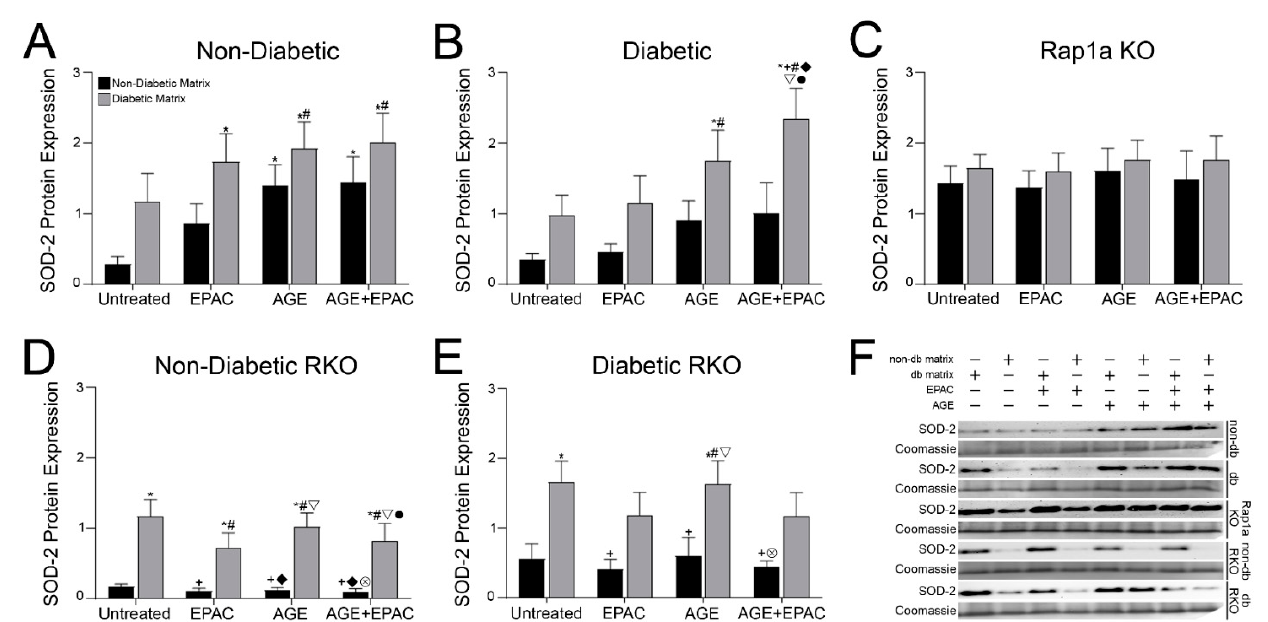
Figure 6. Diabetic matrix and AGE/RAGE signaling impacted expression of SOD-2 in cardiac fibroblasts. Isolated cardiac fibroblasts from ( A ) non-diabetic, ( B ) diabetic, ( C ) Rap1a KO, ( D ) non-diabetic RKO, and ( E ) diabetic RKO mouse hearts and embedded in non-diabetic (black bars) and diabetic (grey bars) matrices. Quantification of Western blot analysis for SOD-2 (25 kDa) was conducted and normalized to total protein (Brilliant Blue Coomassie Stain) in EPAC (100 μ M), exogenous AGEs (0.05 mg/mL) and EPAC+exogenous AGEs (100 μ M and 0.05 mg/mL, respectively) cardiac fibroblasts. ( F ) Representative Western blot images for SOD-2 protein expression in cardiac fibroblasts and non-db = non-diabetic matrix and db matrix = diabetic matrix. Data are means ± SEM with n = 5–10. Statistical analysis consisted of a two-way ANOVA followed by a Fisher’s Least Significant Difference post hoc. Symbols above each bar indicate significance between a specific group ( p < 0.05; * vs. untreated in non-db, + vs. untreated in db, # vs. EPAC in non-db, (cid:117) vs. EPAC in db, (cid:53) vs. AGE in non-db, ⊗ vs. AGE in db, and • vs. AGE+EPAC in non-db). Untreated treatment groups presented were initially presented in Figure 3D.